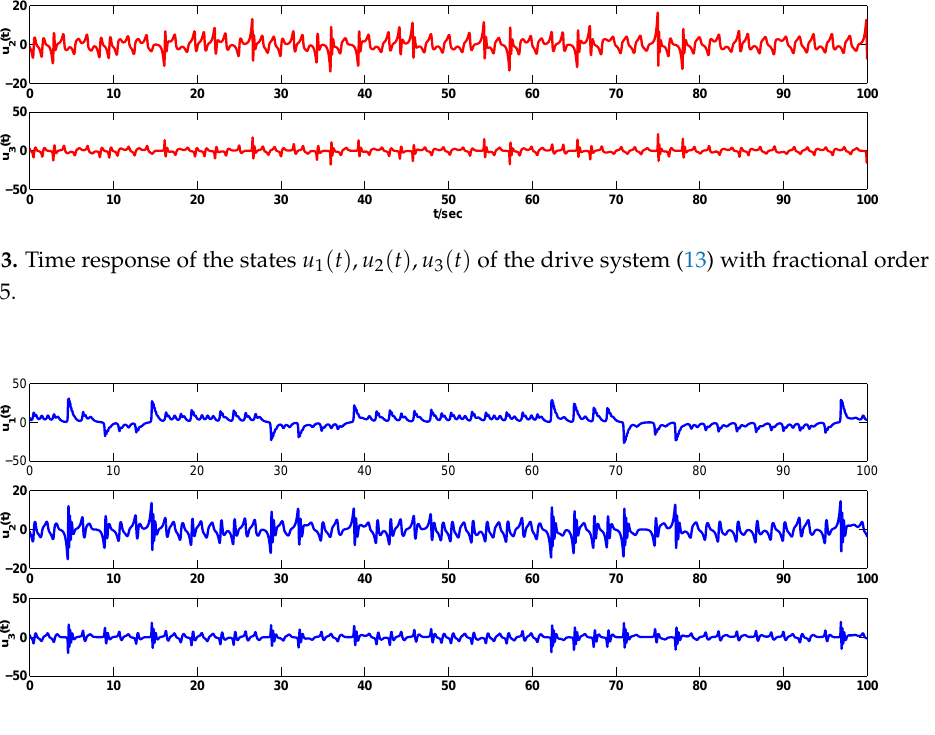
Figure 4. Time response of the states u 1 ( t ) , u 2 ( t ) , u 3 ( t ) of the drive system (13) with fractional order q =